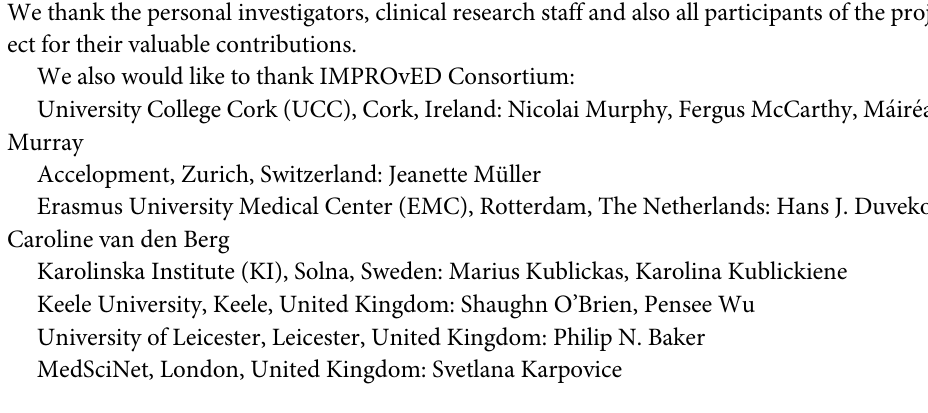
S1 Table. Survey for healthcare professionals. S2 Table. CHEERS